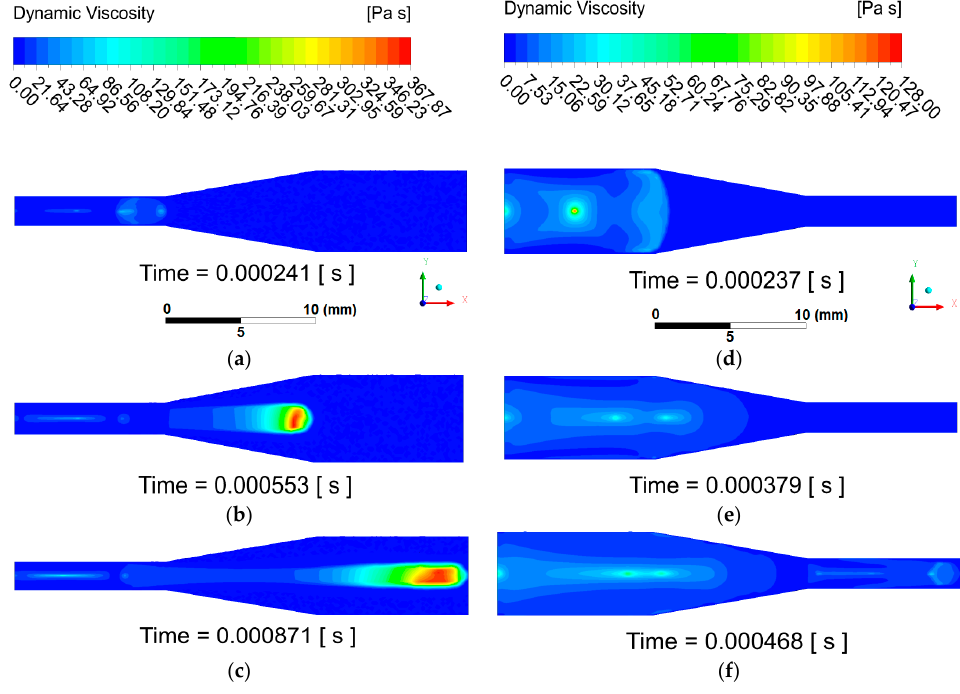
Figure 11. Dynamic viscosity results of ( a ) diffuser case in the first selected timestep, ( b ) diffuser case in the second selected timestep, ( c ) diffuser case in the third selected timestep, ( d ) confusor case in the first selected timestep, ( e ) confusor case in the second selected timestep and ( f ) confusor case in the third selected timestep.